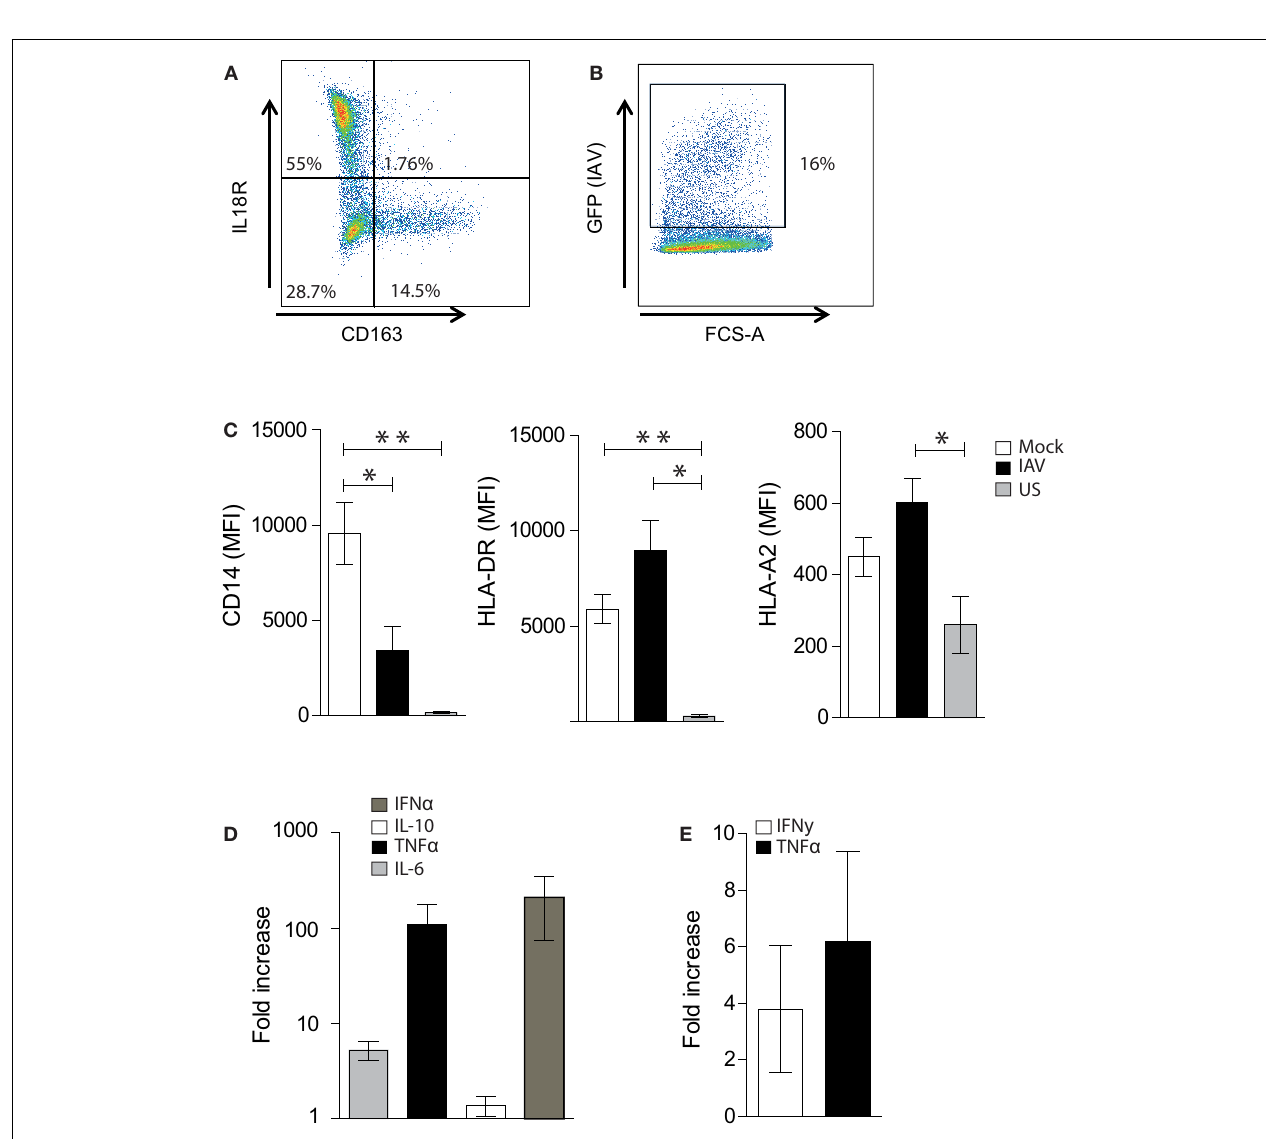
production 16h post-IAV or mock infection of MDMs. Data are expressed as the fold increase in cytokines produced by IAV-infected MDMs relative to mock-infected MDMs. Data are pooled from three independent donors and are shown as the mean ± SEM. (E) Fold increase in the percentage ofTNF- α + or IFN- γ + cells amongst CD3 + CD8 + cells following co-incubation with GLC-pulsed PBMCs, followed 1week later by co-incubation with irradiated C1R-A2 cells pulsed with GLC (2 × rounds of amplification). Data is expressed relative to the percentage ofTNF- α + or IFN- γ + cells amongst CD3 + CD8 + cells following in vitro amplification by co-incubation with GLC-pulsed PBMCs (1 × round of amplification). Data are pooled from two independent donors and are shown as the mean ±